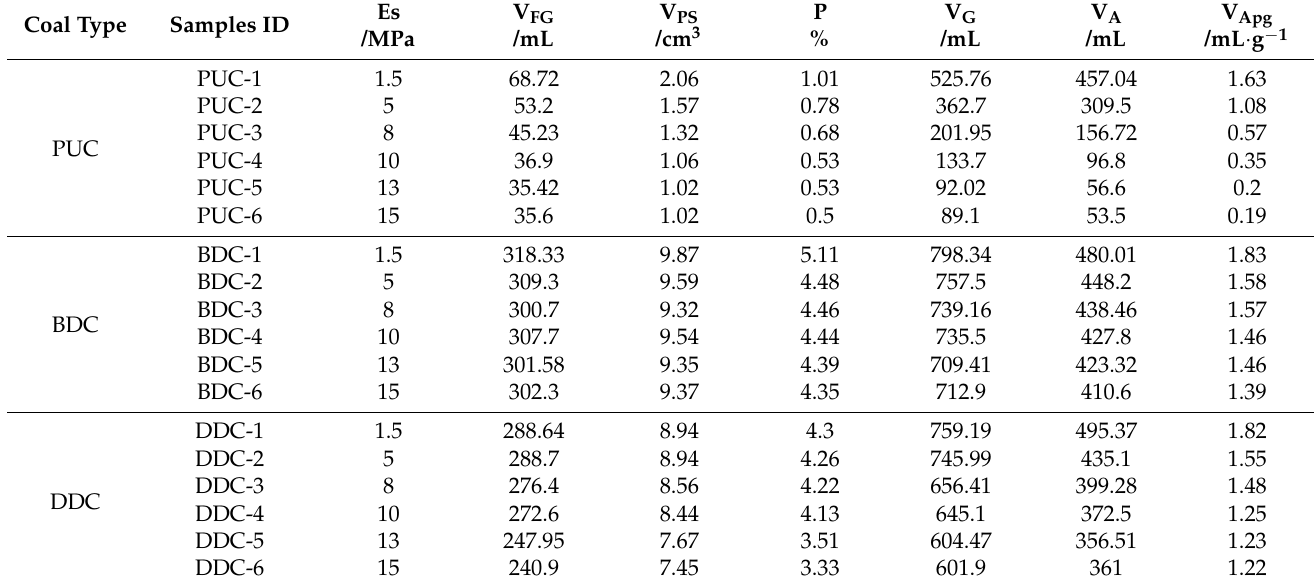
Table 3. The adsorption parameters of coal core samples under effective